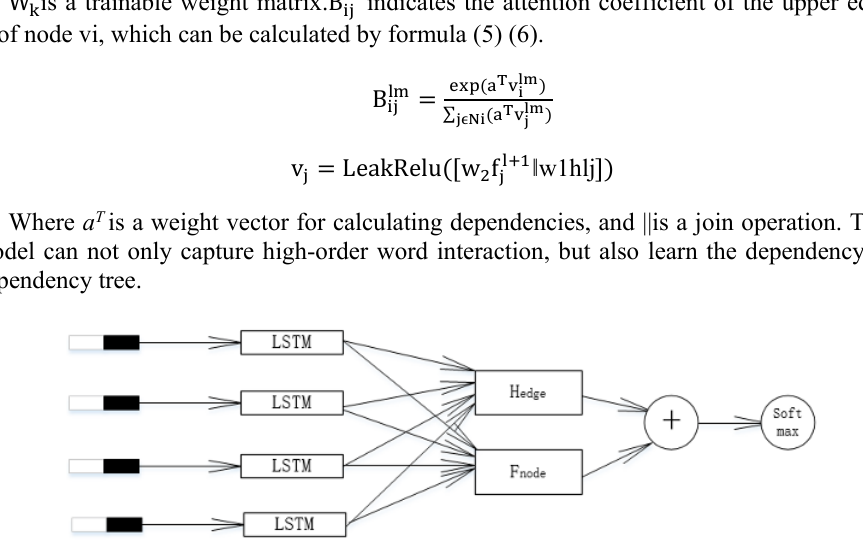
Fig. 2. Overall framework of graph attention neural